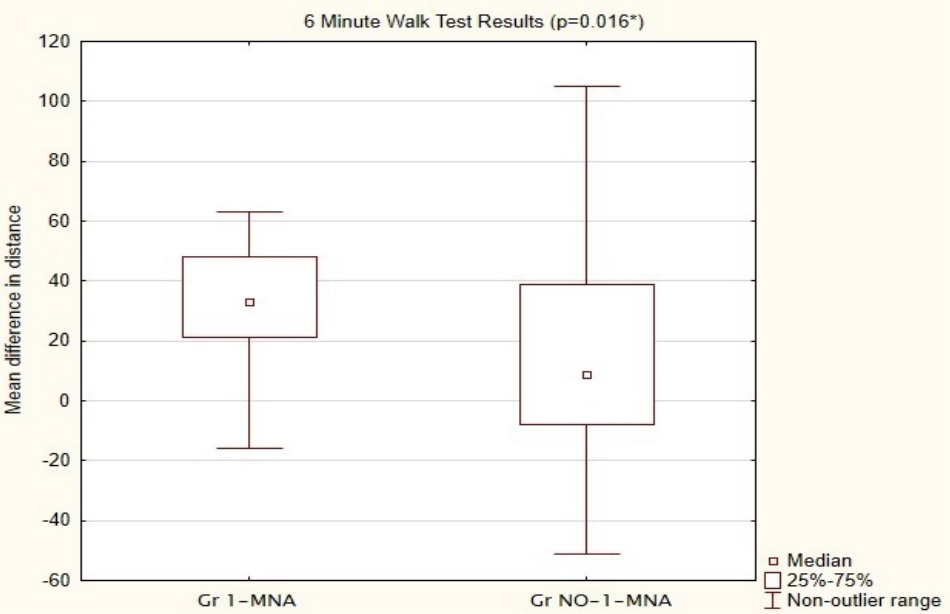
Figure 1. Comparison of mean differences in distance between Group NO-1-MNA and 1-MNA in 6MWT after 1 month supplementation with 1-MNA. Gr NO-1-MNA—patients without supplementation; Gr 1-MNA-patients with 1-MNA supplementation; 6MWT—6-min walk test. * U—Mann−Whitney test.